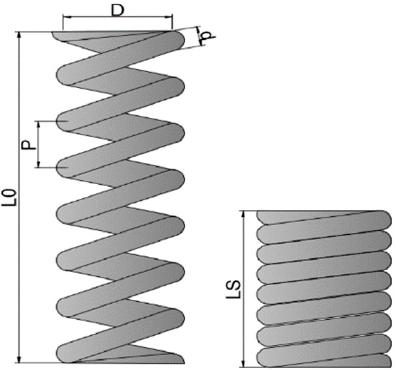
Figure 11. Schematic diagram of spring extension/compression structure.